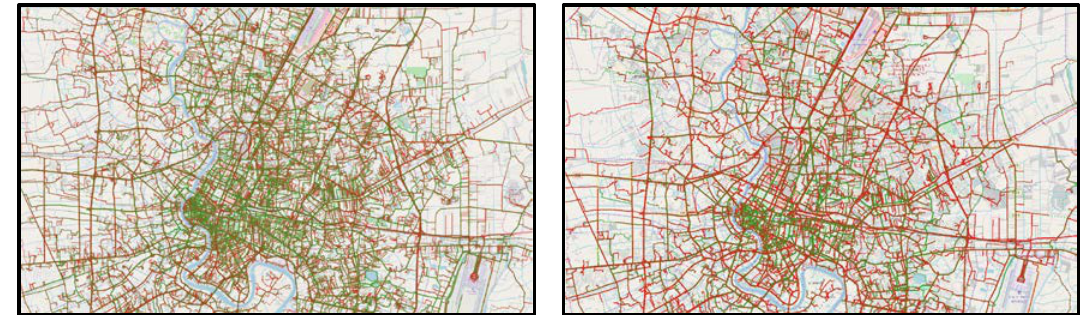
Figure 20. Simulated trajectory of taxi agent for one day. Left: Weekday; Right : Weekend.